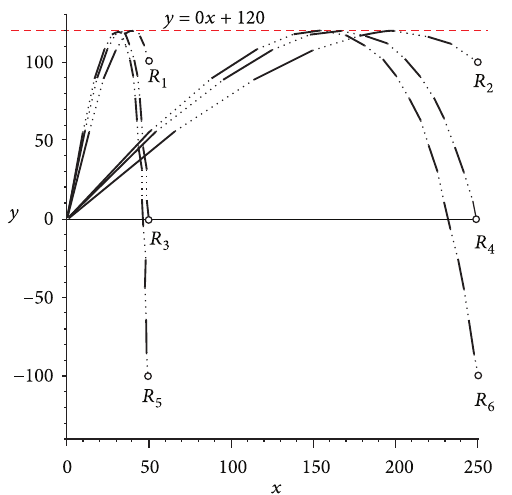
Figure 10: Planning trajectories through 𝑄 and six different 𝑅 targets.